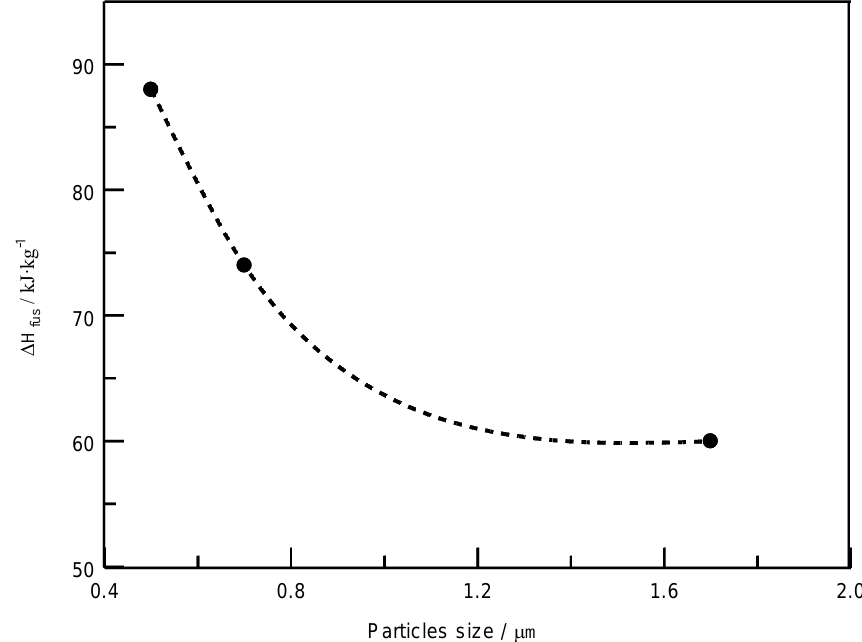
 of PP 75%/ EPTSR 25% polymer blend. Figure 19. fus